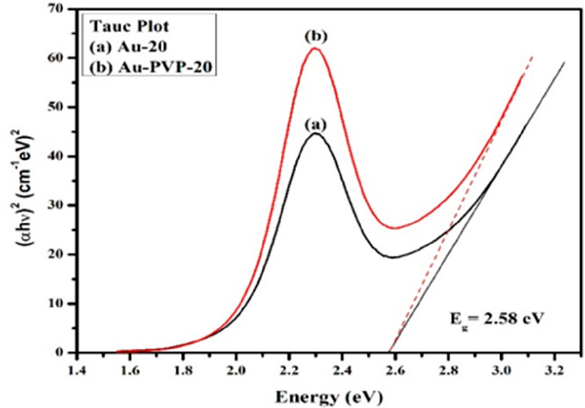
Figure 8. Optical band gap using the Tauc Plot for ( a ) Au-20 and ( b ) Au-PVP-20.